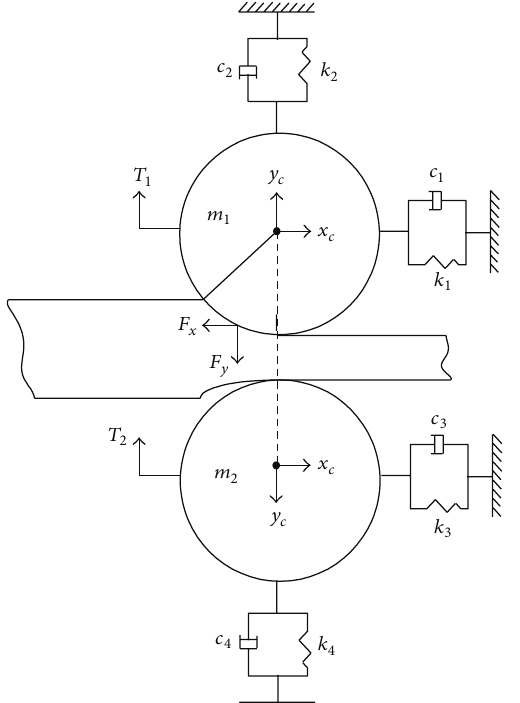
Figure3:Thevertical-horizontalcouplingdynamicmodelofrolling mill